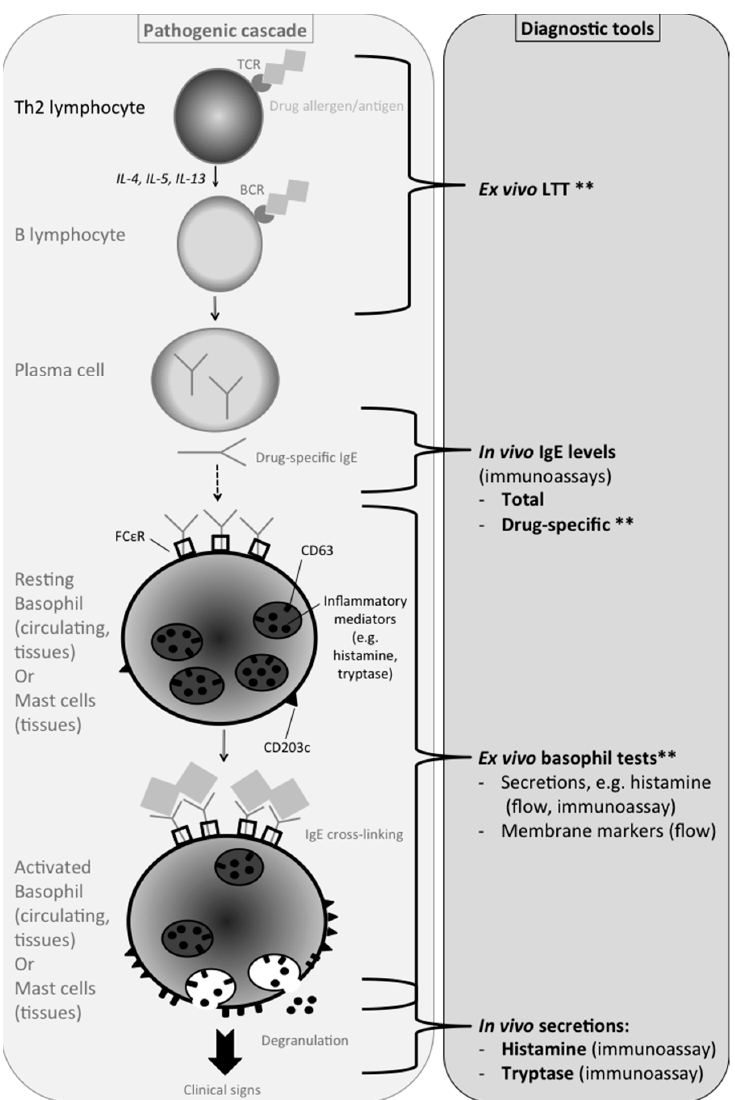
Figure 1. In vitro tests available based on the pathogenic events involved in immediate drug AHR. TCR = T cell receptor; BCR = B cell receptor; IgE = Immunoglobulin class E; Fc ε R = IgE receptor; LTT = Lymphocyte Transformation Test; ** tests that also confirm the nature of the culprit drug; “in vivo”: marker secreted in the patient during the reaction, but measured in vitro in a blood sample; “ex vivo”: a marker secreted in vitro by the patient’s cells.